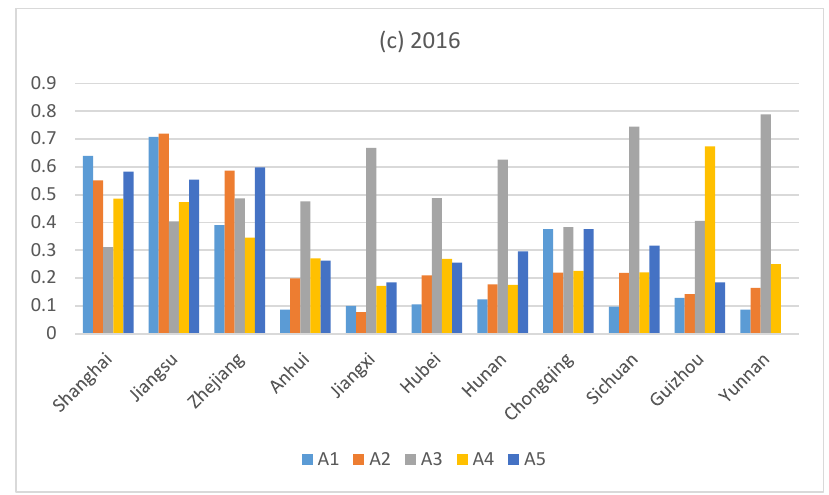
Figure 4. Carbon emission reduction subsystem score.